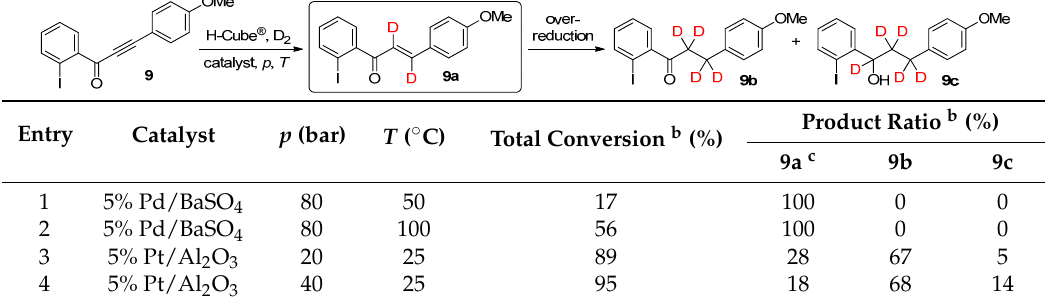
Table 5. Continuous-flow deuteration of 9 a .